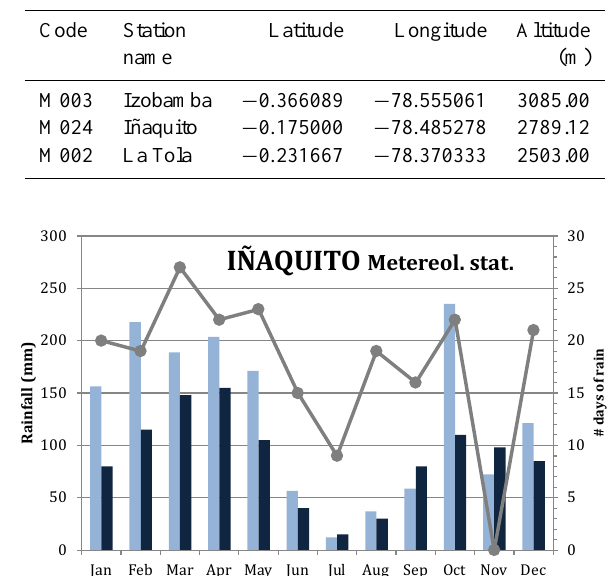
Figure 1. Total monthly rainfall, average multiannual rainfall (of the available data) number of days with rain per month (higher than 0.1mm) of the closest meteorological station to El Trebol be- ing Iñaquito. From National Institute of Meteorology and Hydrol- ogy